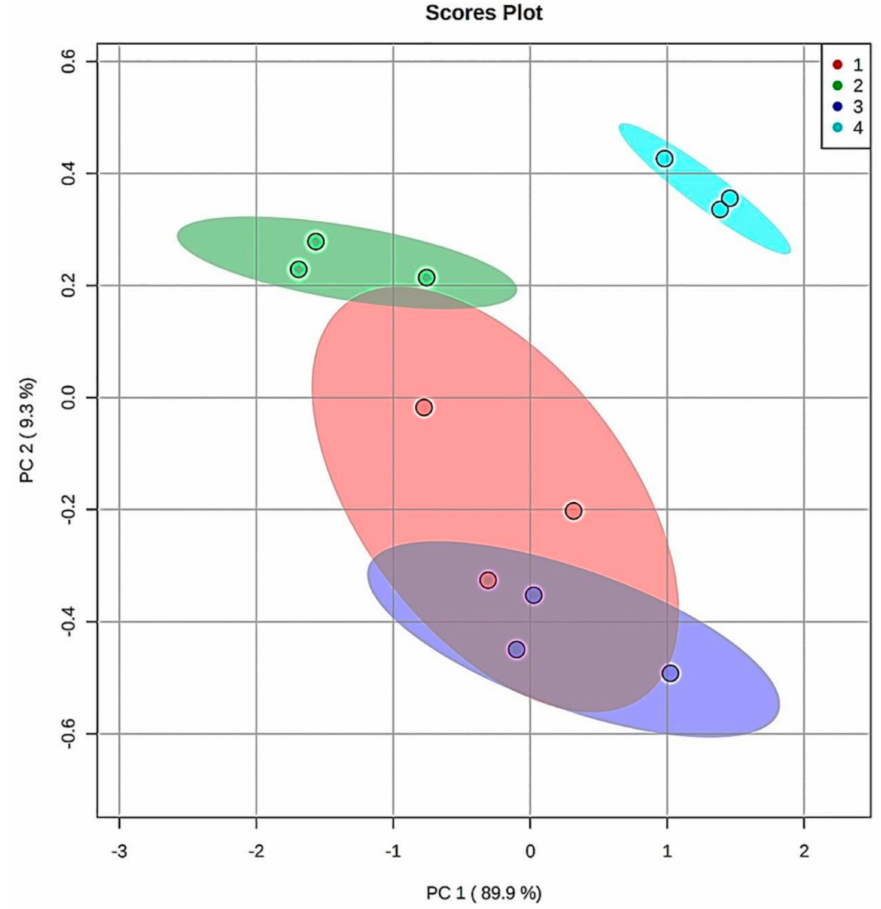
Figure 4. Multivariate Chemometric Clusterings and ROC curve analysis of Aldehyde Classification Patterns Formed in CLO Products at the 90 min. TSE Time-Point. Principal component analysis